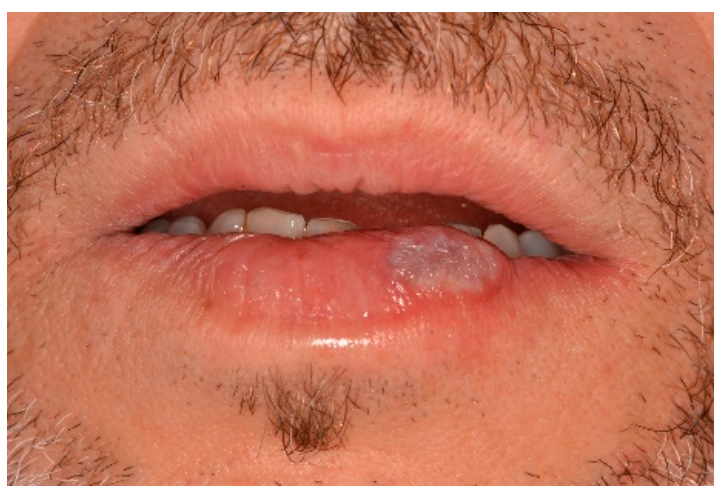
Figure 8. The lesion was treated by transmucosal photo-thermo-coagulation after topical anesthesia application. An Nd:YAG laser was used.